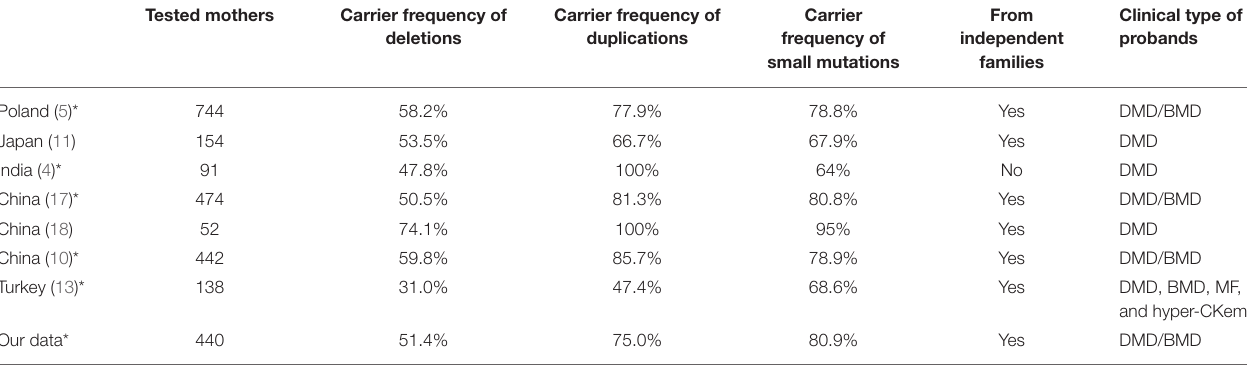
TABLE 4 | Carrier frequency of DMD/BMD based on different variant types in different